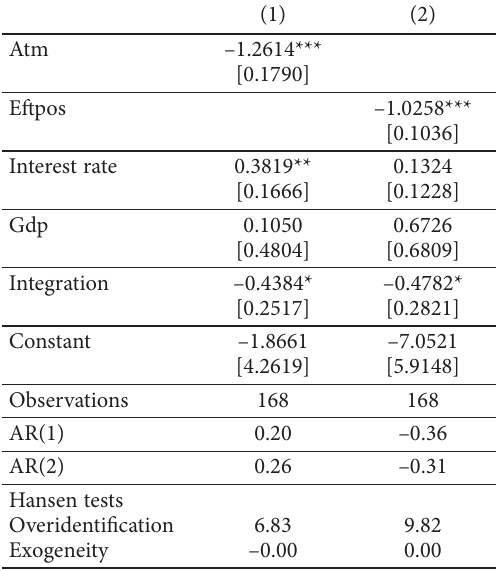
Table 4. Robustness analysis: GMM